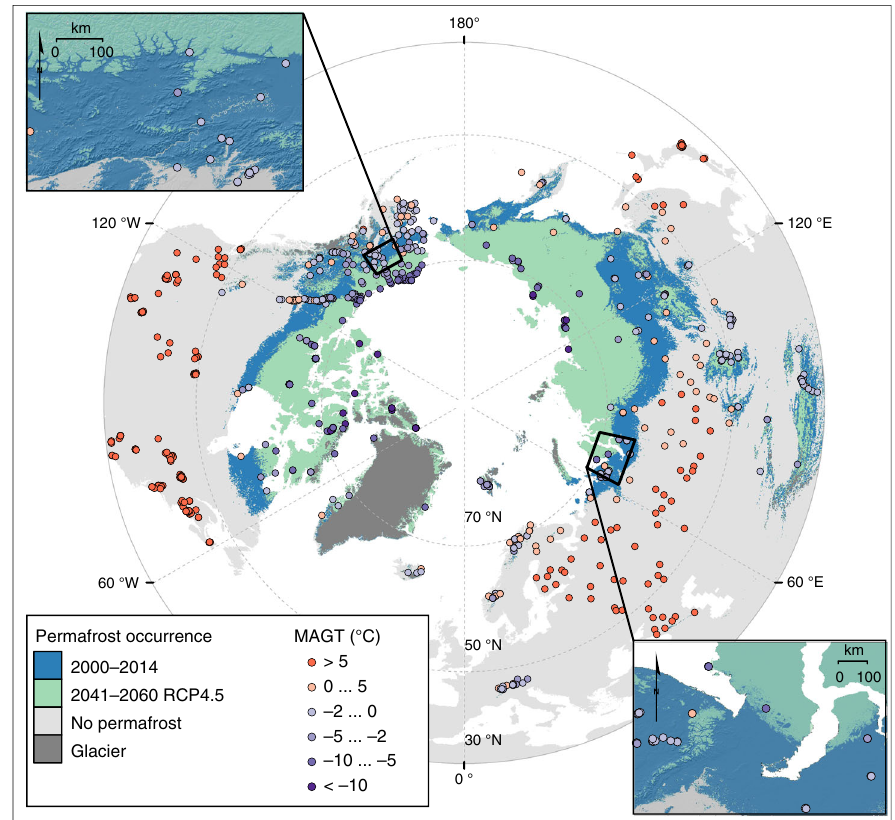
Fig. 1 Distribution of permafrost in the baseline (2000 – 2014) and future (Representative Concentration Pathway 4.5 2041 – 2060) climates 23 . Note that the baseline extent of permafrost (blue) includes future distribution (greenish). The location and observed mean annual ground temperature (MAGT) of the data points (boreholes) are shown with coloured